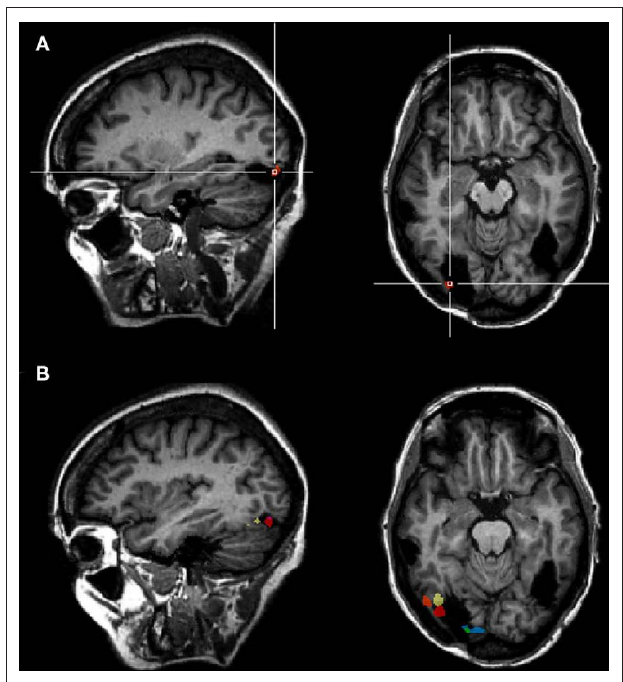
Figure A2 | (A) As illustrated previously (Figure 6 in Rossion et al., 2003), the average coordinate of the right OFA in normal participants tested with the face localizer used in the present study falls within PS ′ right inferior occipital lesion (Talairach normalized brains, here the localization of the right OFA using the contrast (faces–cars) and (faces–scrambled faces) in 40 right handed participants included in a meta-analysis in preparation). (B) In addition, 9 of the 11 individually defined right OFAs of participants of the present study fall entirely or largely within the lesion site. Most importantly, across many studies, PS never showed any face-preferential activation around the lesion that could have been taken as a right